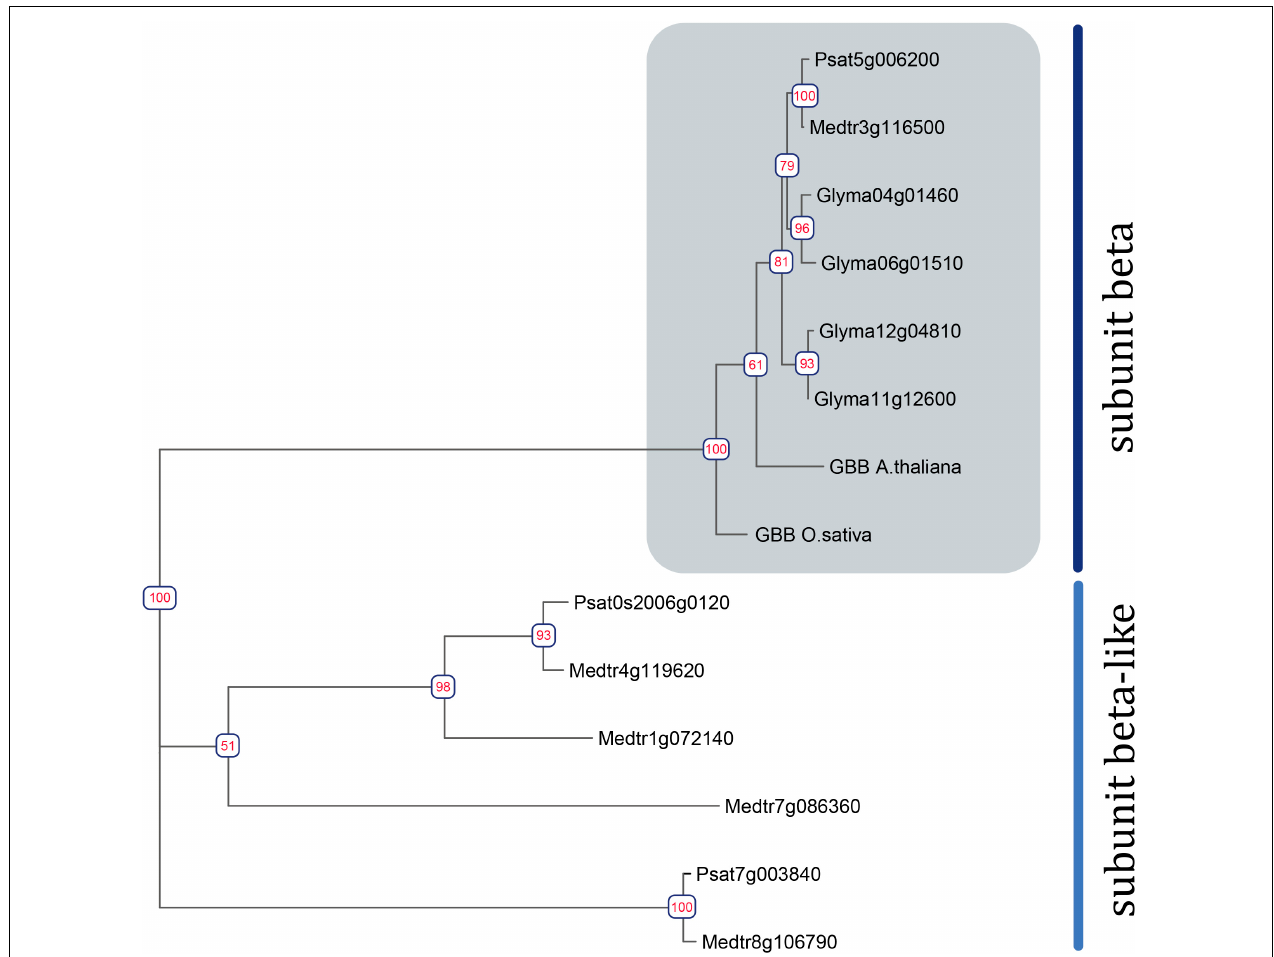
FIGURE 1 | Phylogenetic tree constructed using the Maximum-Likelihood method based on amino acid sequences of G. max and A. thaliana Gbeta genes and their homologous identified in P. sativum and M. truncatula genomes. Numeric values indicate branch support based on 1000 UltraFast bootstrap